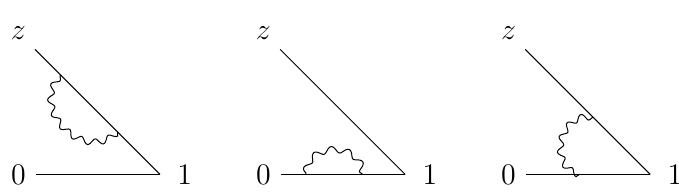
Figure 1 . Contributions to the three point blocks from the networks of open Wilson lines at the 1 =c order. The solid and wavy lines represent an open Wilson line and the propagation of a spin s current with s = 2 ; 3 =